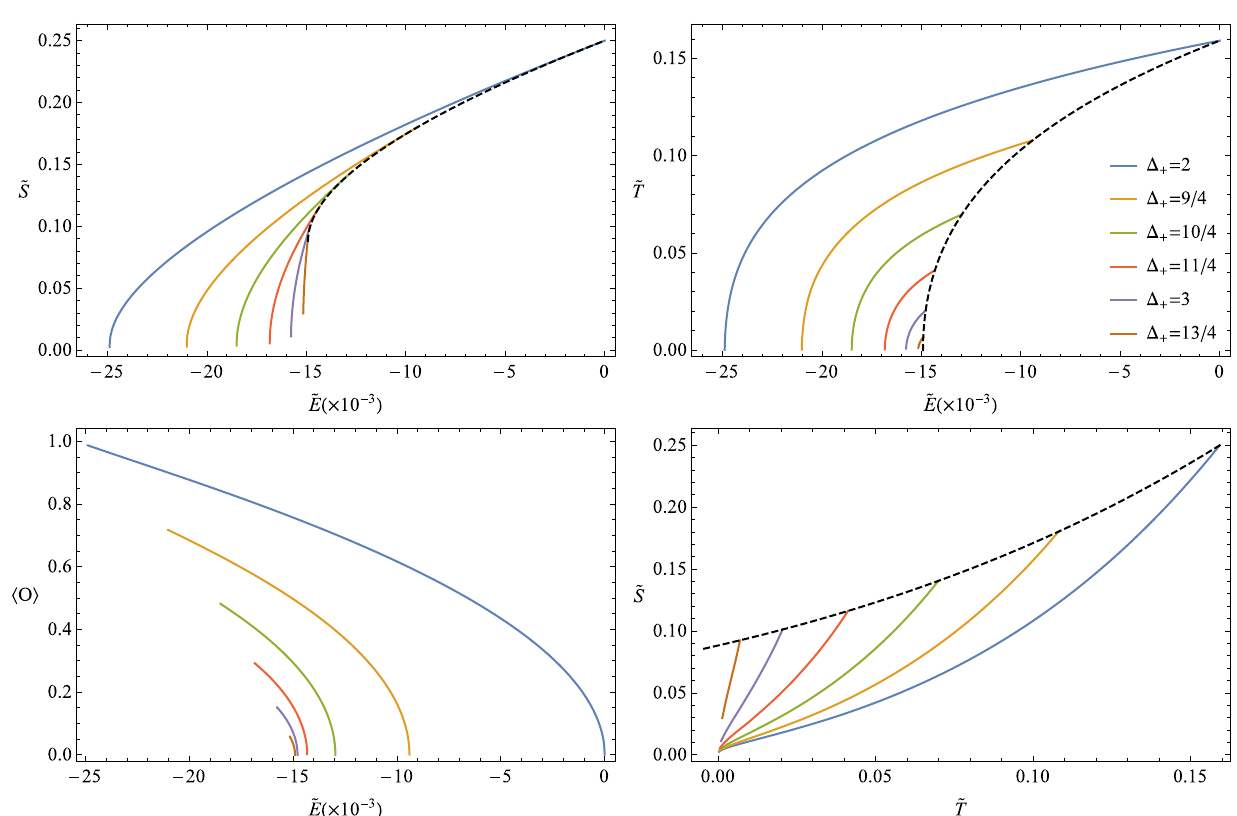
Fig. 3 Thermodynamical quantities for various values of (cid:16) + . Note that the colors in this figure match with those of Fig. 2. The dashed black curve represents the Einstein black hole solution and the solid curves belong to the hairy black holes